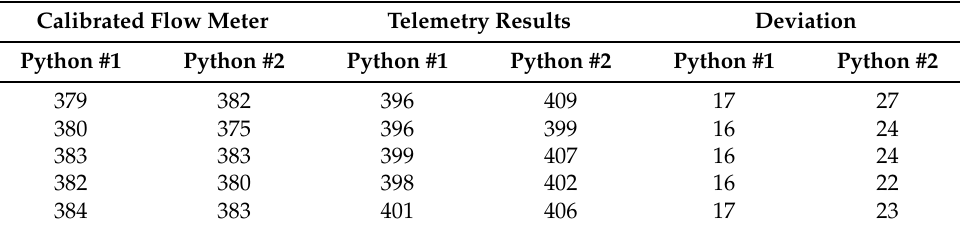
Table 2. Number of impulses in fast tapping during 10 s period for 1